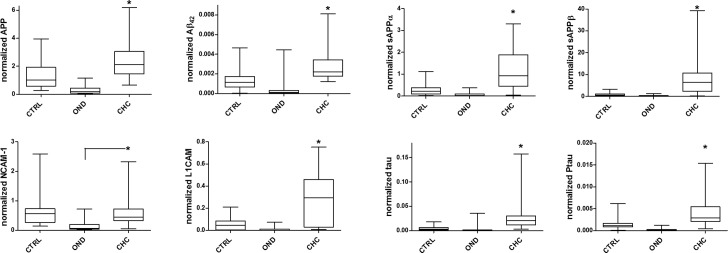
CSF biomarker levels in control, congenital hydrocephalus, and other neurological diseases.Box and whisker plots comparing normalized levels of CSF biomarkers measured in control, other neurological diseases (OND), and congenital hydrocephalus (CHC) subjects across all ages. Note the significant (*, p<0.05) increases in APP, Aβ42, sAPPα, sAPPβ, L1CAM, NCAM-1, tau, and pTau in CHC compared to both control and OND cases.